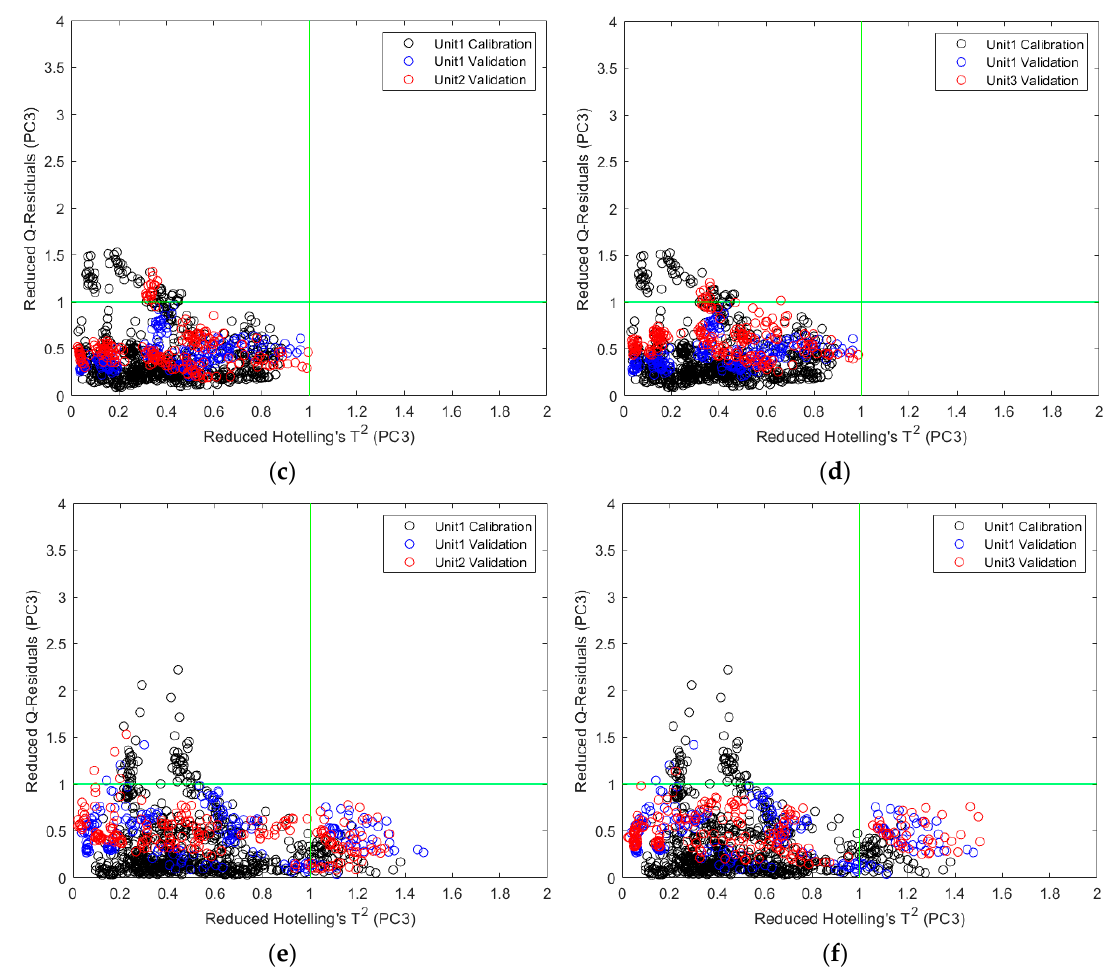
Figure 5. Reduced Q residuals versus reduced Hotelling’s T 2 for models developed on Unit 1: ( a ) validation sets by Unit 1 and Unit 2 for ASA prediction; ( b ) validation sets by Unit 1 and Unit 3 for ASA prediction; ( c ) validation sets by Unit 1 and Unit 2 for ASC prediction; ( d ) validation sets by Unit 1 and Unit 3 for ASC prediction; ( e ) validation sets by Unit 1 and Unit 2 for CAF prediction; ( f ) validation sets by Unit 1 and Unit 3 for CAF prediction.